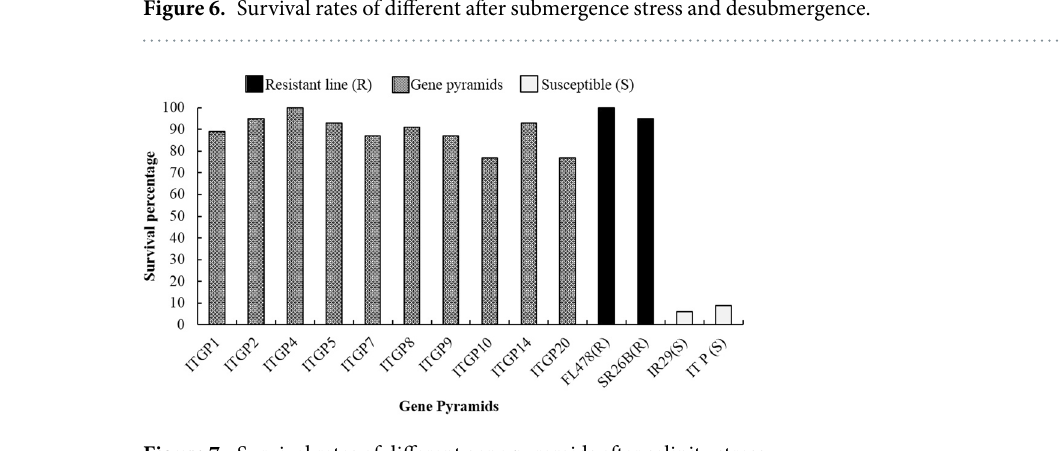
Figure 7. Survival rates of different gene pyramids after salinity stress.